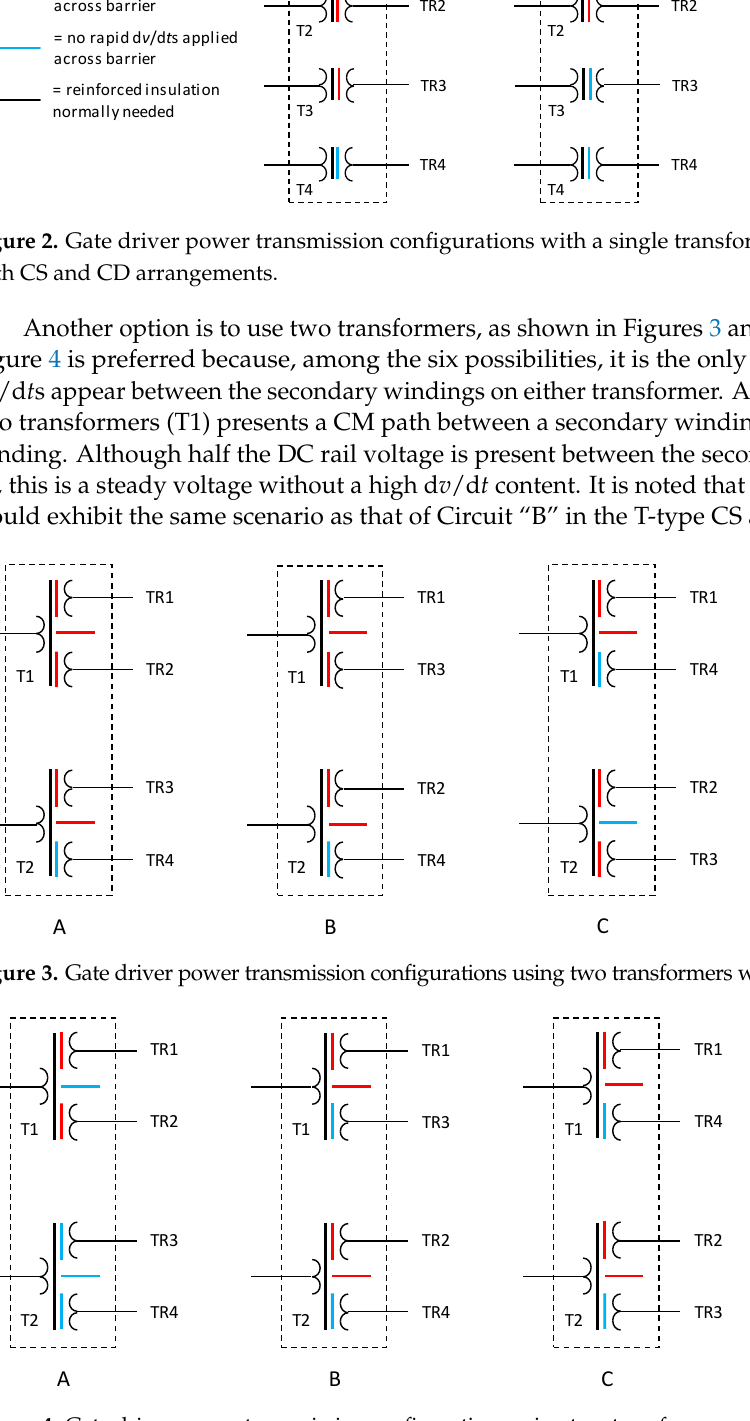
Figure 4. Gate driver power transmission configurations using two transformers with CD arrange- ment.